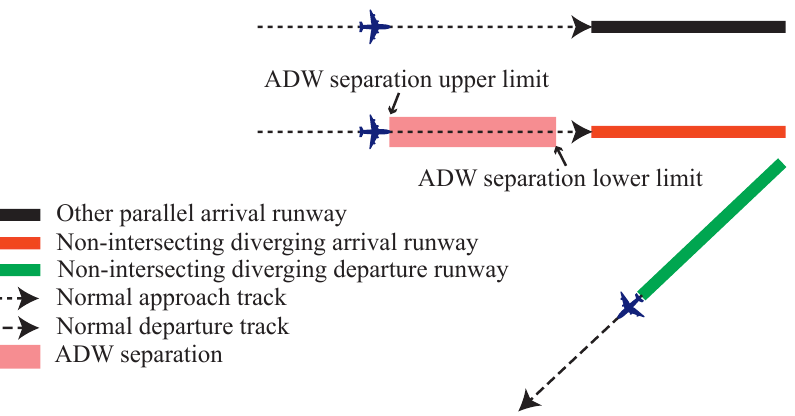
Figure 2. Schematic diagram of the arrival and departure window (ADW)